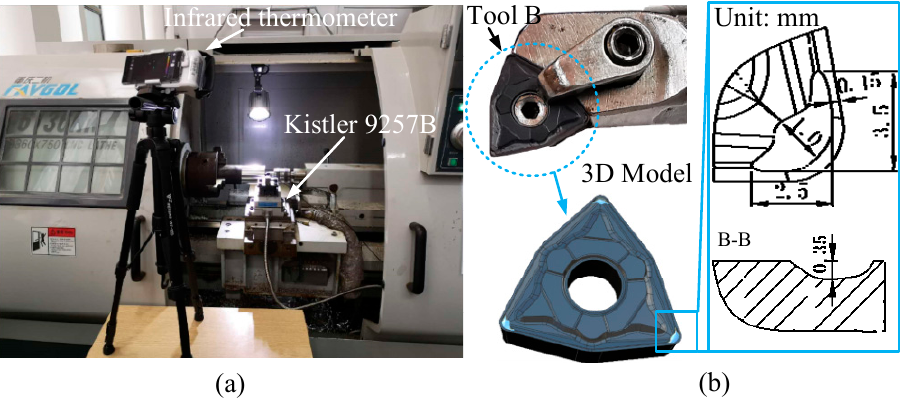
Figure 3. ( a ) CNC Machine and testing equipment. ( b ) Tool B and micro-groove dimensions.